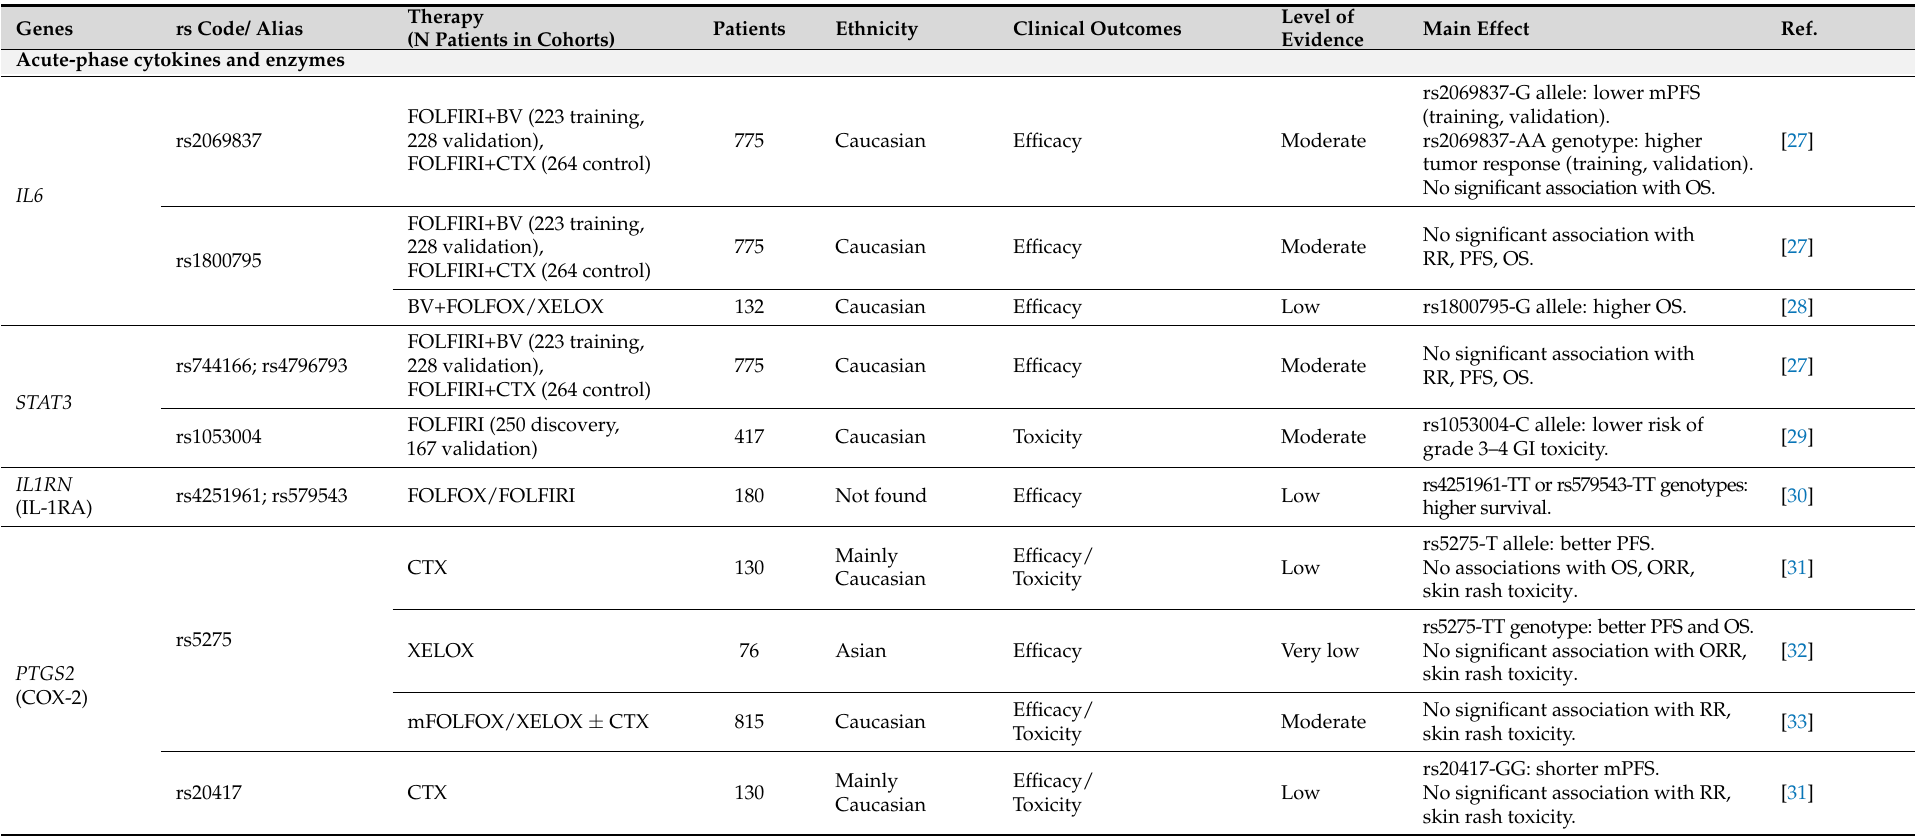
Table 1. Summary of the efficacy and toxicity evidence for immune-related genes divided in 8 groups belonging to the acute-phase/innate and adaptive immune